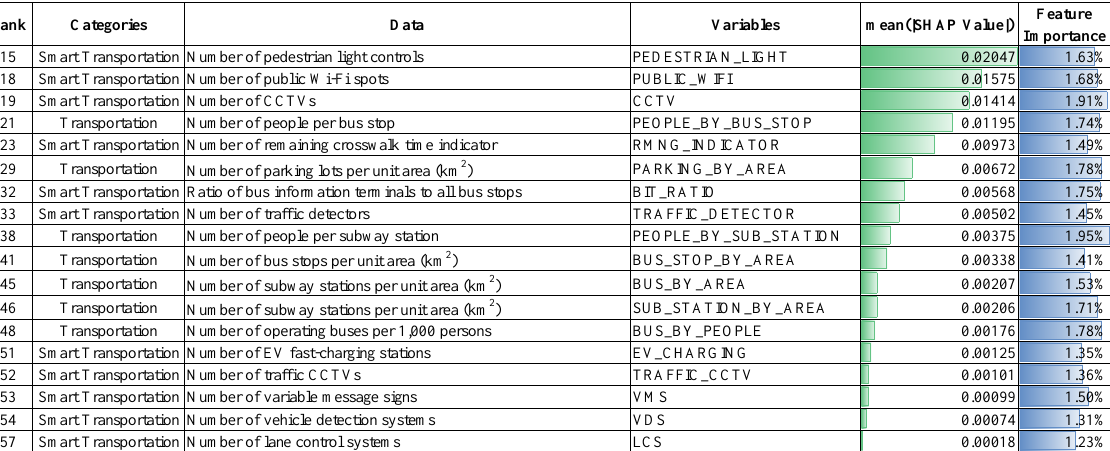
Figure 9. Transportation-related features in order by mean absolute SHAP values.